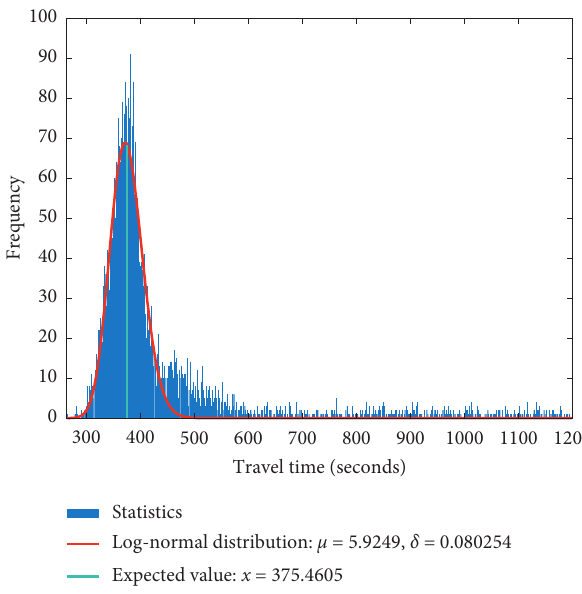
Figure 2: Travel time